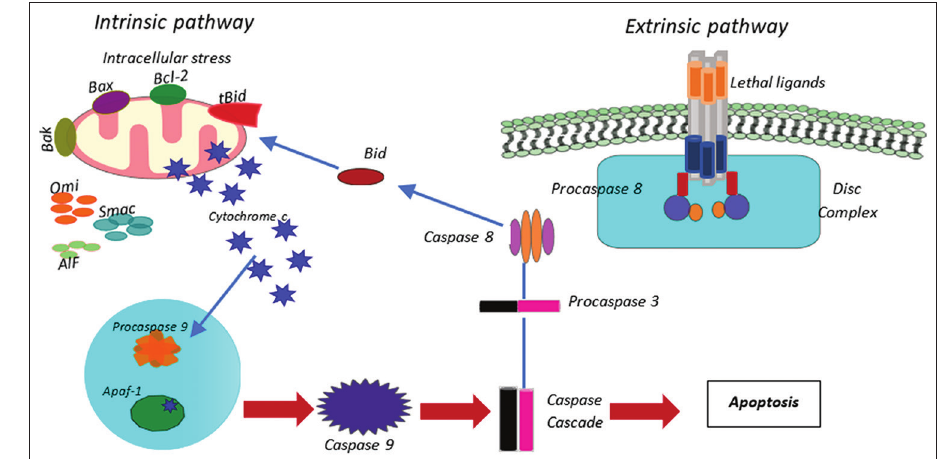
Figure-1: Pathways of apoptosis. [52].